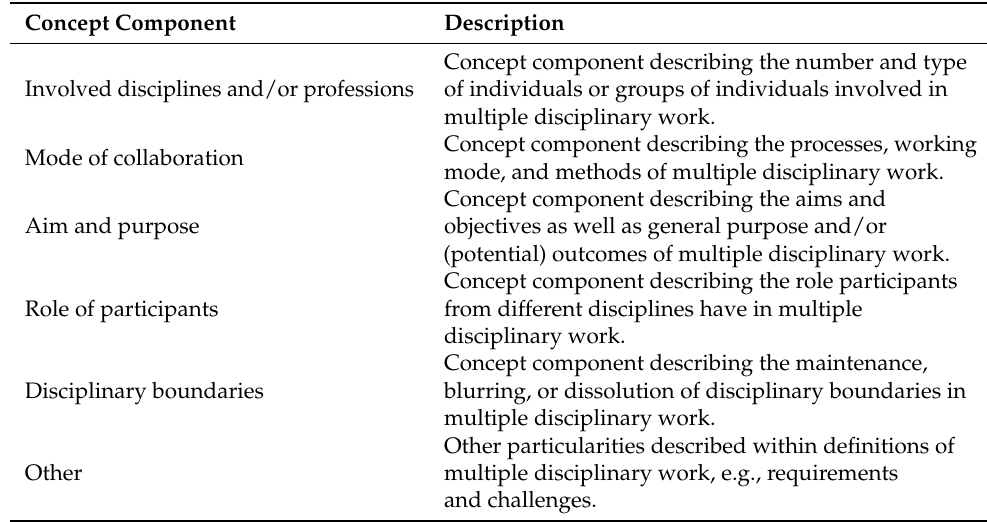
Table 3. Concept components of definitions of multi-, inter-, and transdisciplinarity in the theoretical literature and